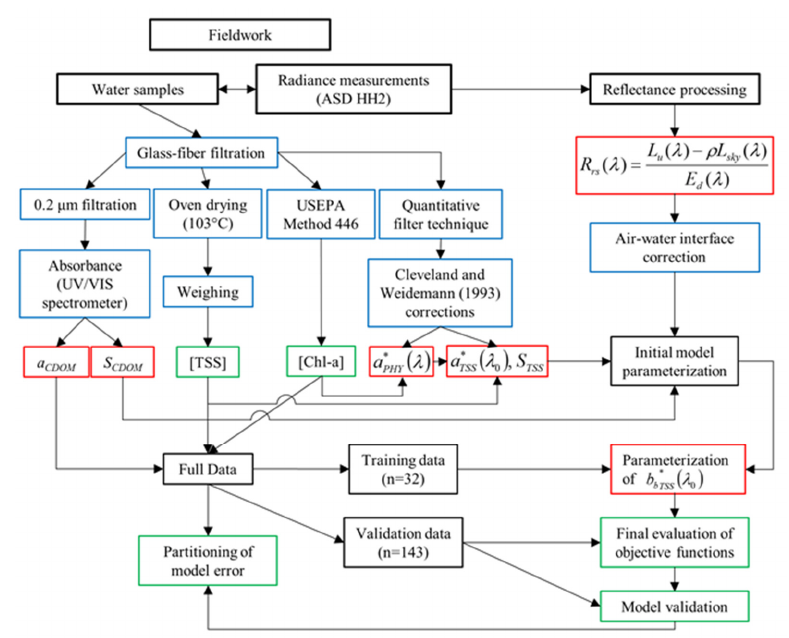
Figure 2. Full workflow used to collect and process field data, optimize and validate the semi-analytical algorithm, and perform statistical analyses. Green outlines refer to final products, red outlines to optical parameters, and blue outlines to intermediate processing steps. [TSS] and [Chl-a] refer to the concentrations of total suspended solids and chlorophyll-a, respectively.